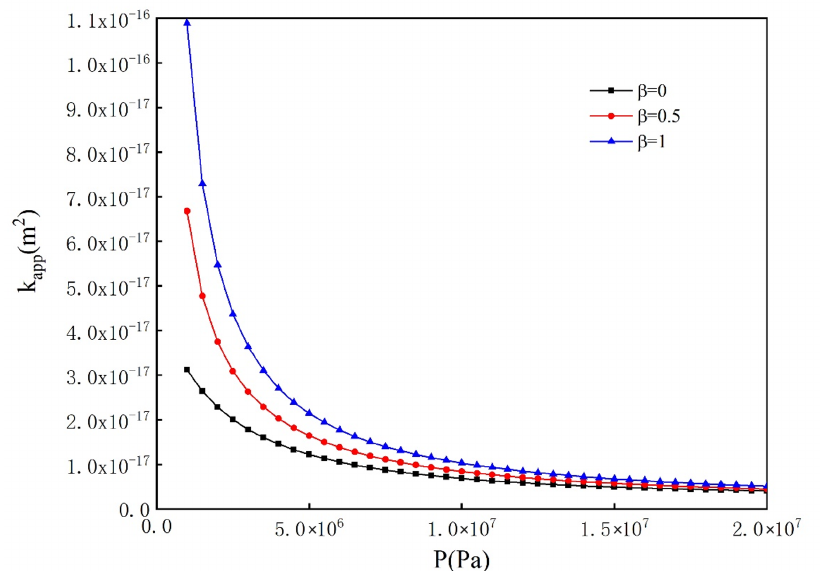
Figure 9. Apparent permeability vs. pressure under different water molecular coverage (r = 5 nm).